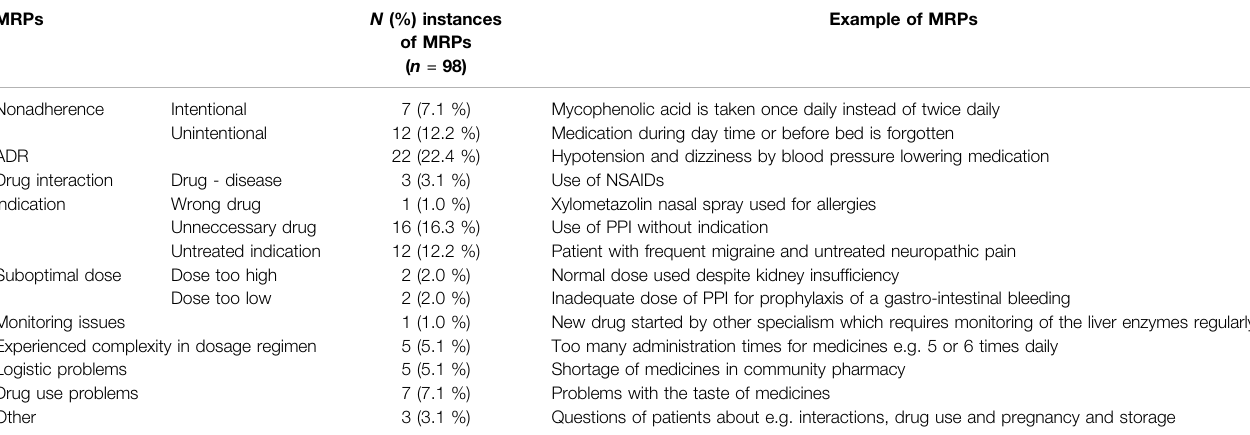
TABLE 3 | Prevalence and examples of